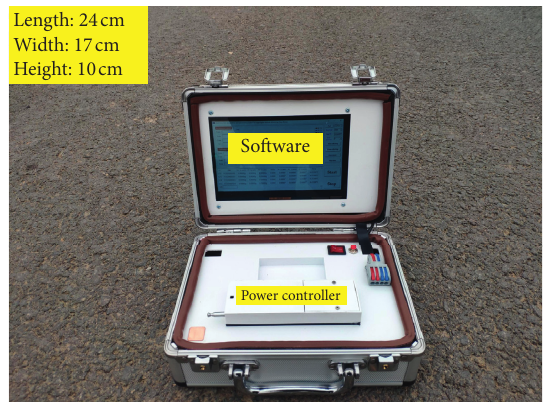
Figure 5: The ISA data acquisition system (IDAS).